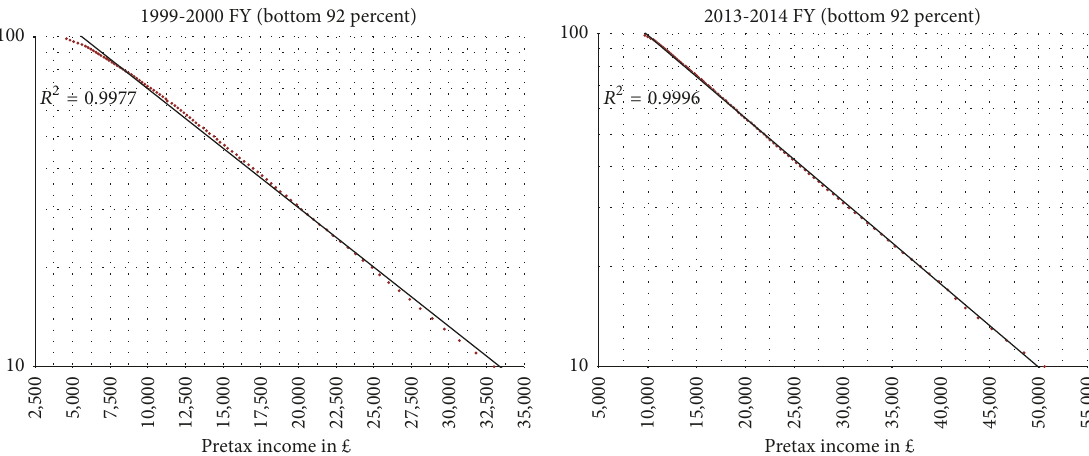
Figure 3: Semilog inverse or counter-cumulative distributions of income in Britain, exponential fits (linear in this space), and their 𝑅 2 . Selected years, bottom 92 percent of taxpayers. Calculated from HM Revenue and Customs